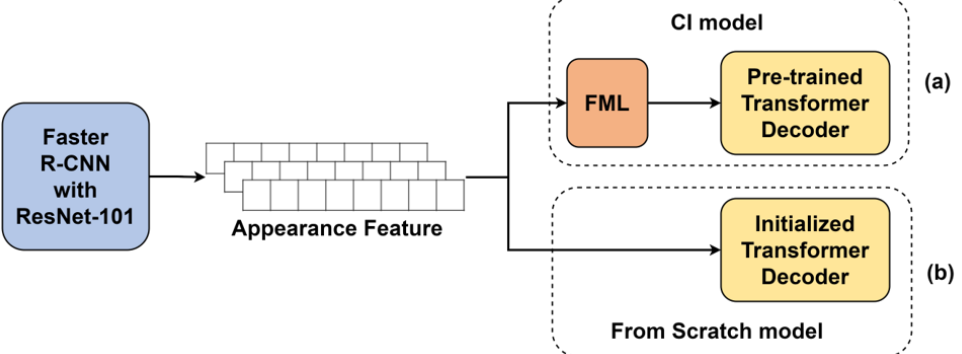
Figure 4. Two models used in the image captioning task. ( a ) Image captioning model using